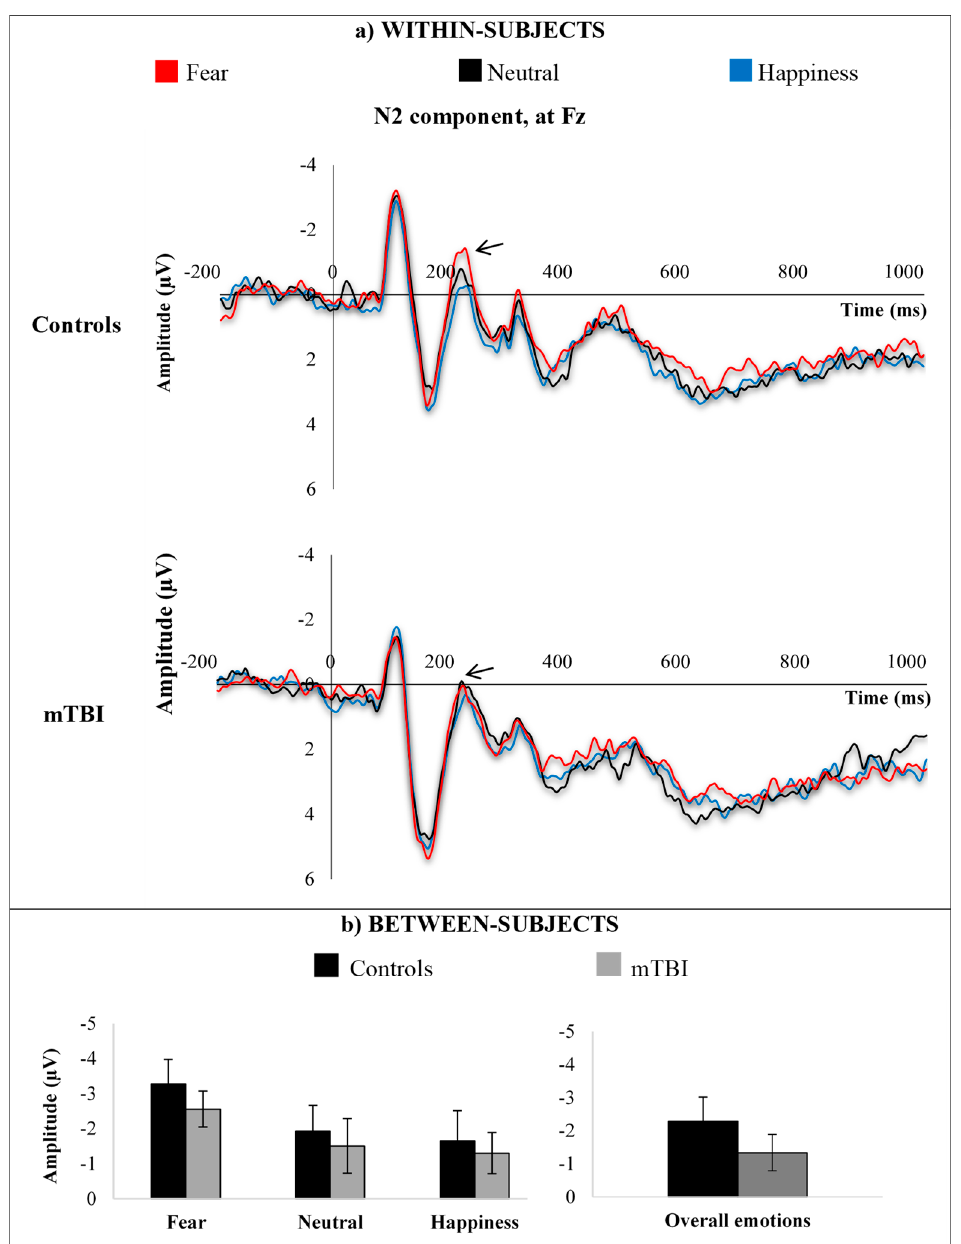
Figure 5. N2 responses at Fz electrodes site, ( a ) within-subjects and ( b ) between-subjects, according to emotional expressions (fear, neutrality, happiness).